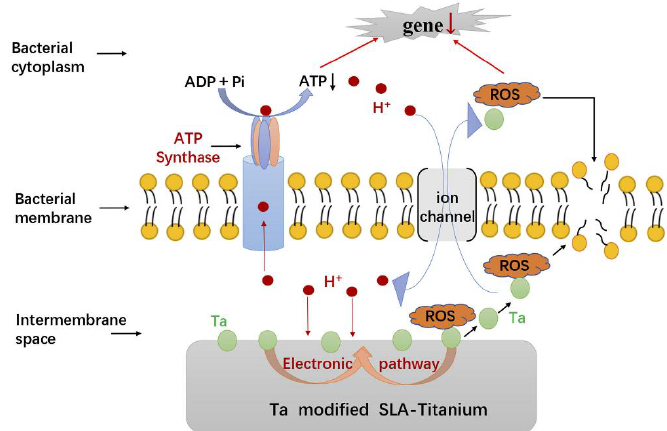
Figure 5. The possible antibacterial mechanisms underlying the antimicrobial activity phenomenon of SLA-Ta surface. Reproduced with permission from ref